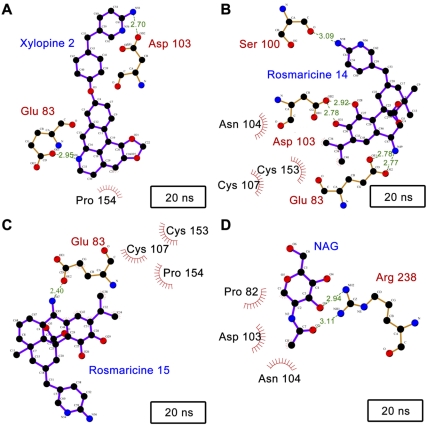
Protein-ligand interactions of TCM candidates and Tamiflu® in H1.H1-ligand interactions following MD are illustrated for (A) Xylopine_2, (B) Rosmaricine_14, (C) Rosmaricine_15, and (D) Tamiflu®. Hydrogen bonds are indicated by green dashed lines between the atoms involved. Amino acids forming H-bonds with the ligand are shown in red. Hydrophobic contacts are represented by arcs with spokes radiating towards the ligand atoms they contact. The contacted atoms are shown with spokes radiating back.